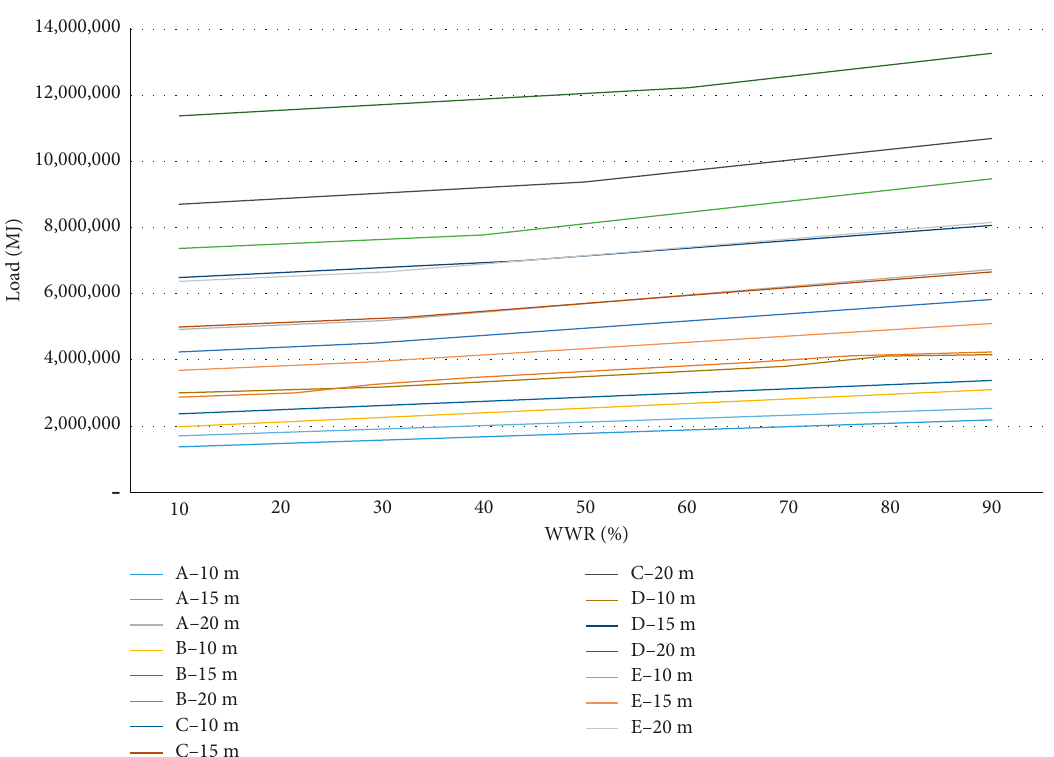
Figure 5: Energy consumption by tower type and size (MJ): residential facilities.